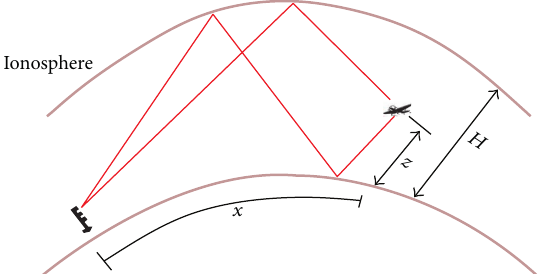
Figure 4: The micromultipath effect in the earth curvature model.